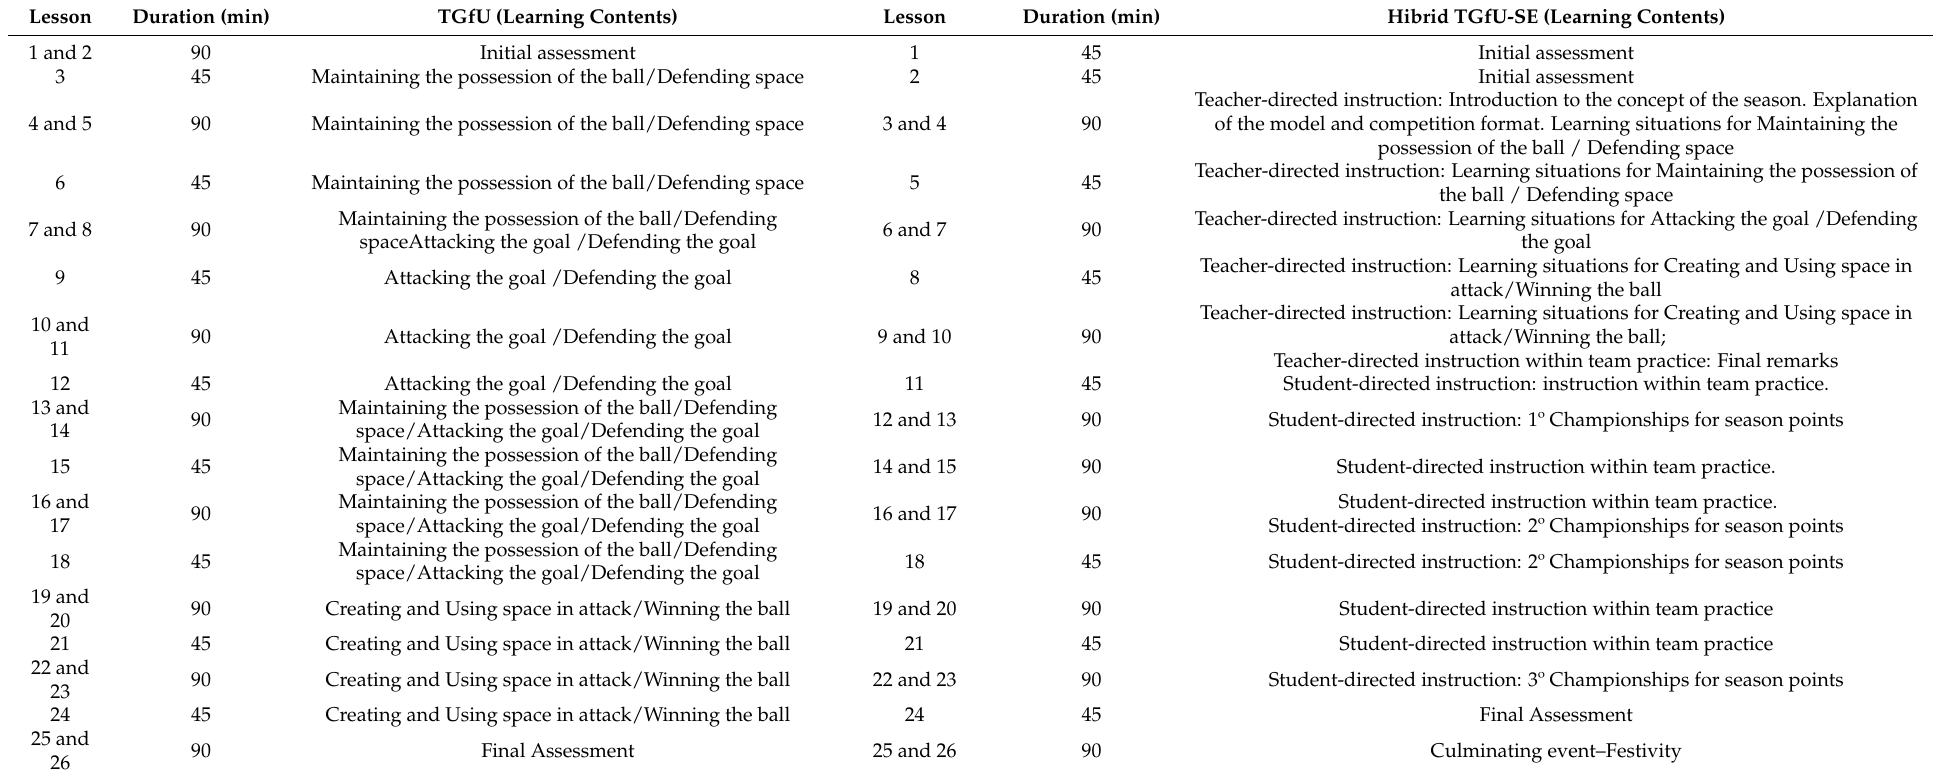
Table 1. Season plan for the hybrid TGfU-SE and TGfU